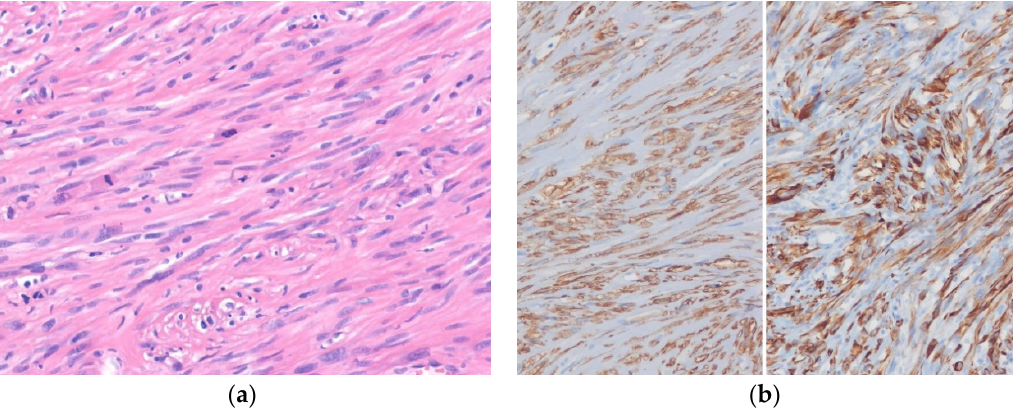
Figure 4. Leiomyosarcoma. ( a ) The tumor cells have cigar-shaped, blunt-ended nuclei with brightly eosinophilic cytoplasm and a fascicular pattern. Mitoses are present. ( b ) The tumor cells are diffusely positive for SMA (left) and desmin (right) (H&E stain, original magnification 20 × a ; SMA and desmin immunostain, original magnification 200 × b ).